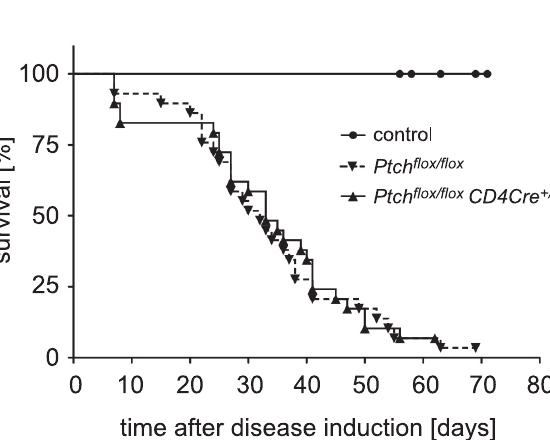
cells from either Ptch flox/flox control or Ptch flox/flox CD4Cre + / 2